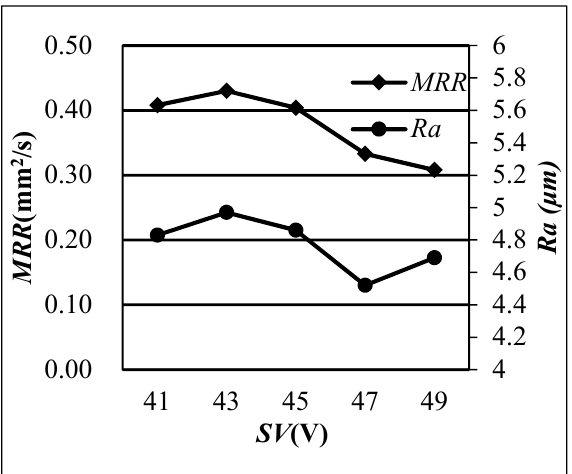
Figure 6. The effect of SV on MRR and SR.